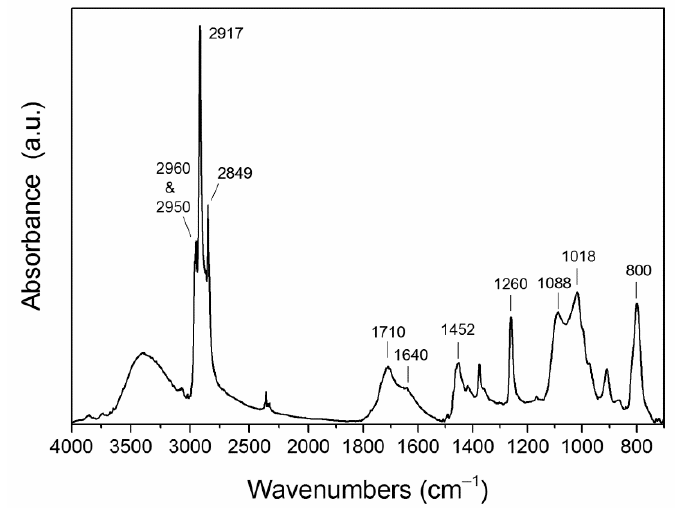
Figure 8. Micro-ATR-FTIR spectrum of the xylene-extractable fraction of